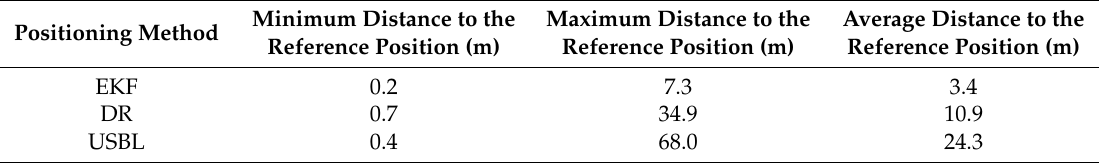
Table 5. Statistical parameters of positioning errors using EKF and DR methods and the USBL system (single passage).